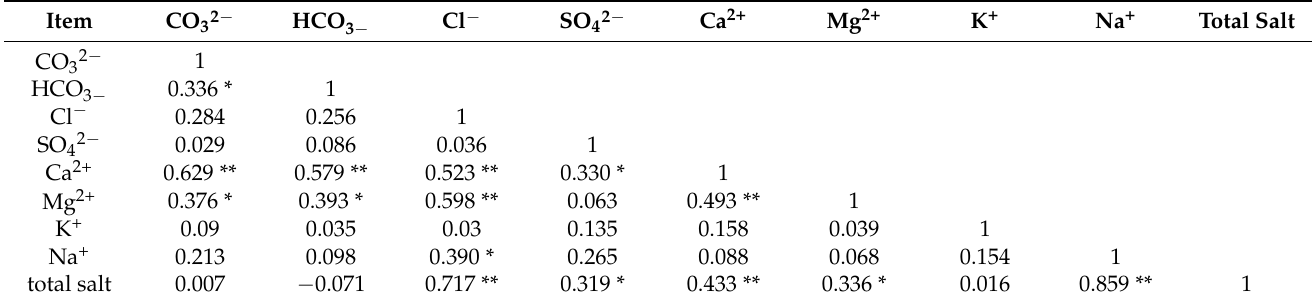
Table 2. Correlation coefficients between total salt and eight major ions in Area